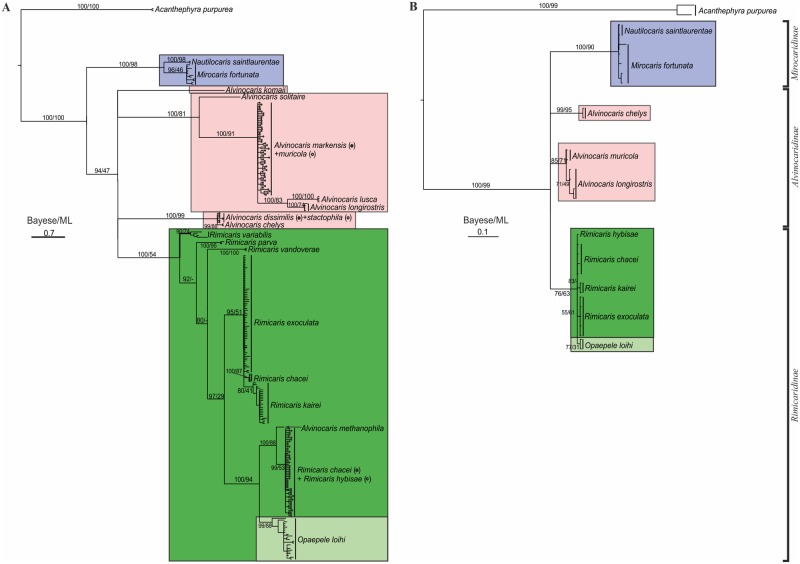
Bayesian phylogenetic trees of the family Alvinocarididae based on COI gene (A) and 16 S gene (B) sequences.The horizontal scale bar marks the number of expected substitutions per site. Statistical support indicated as Bayesian posterior probabilities (left values) and bootstrap analysis with 1,000 replicates (right values) and. Supported clades are marked by different colors: Mirocaridinae (blue), Alvinocaridinae (pink), Rimicaridinae (light green), Rimicaris (green).